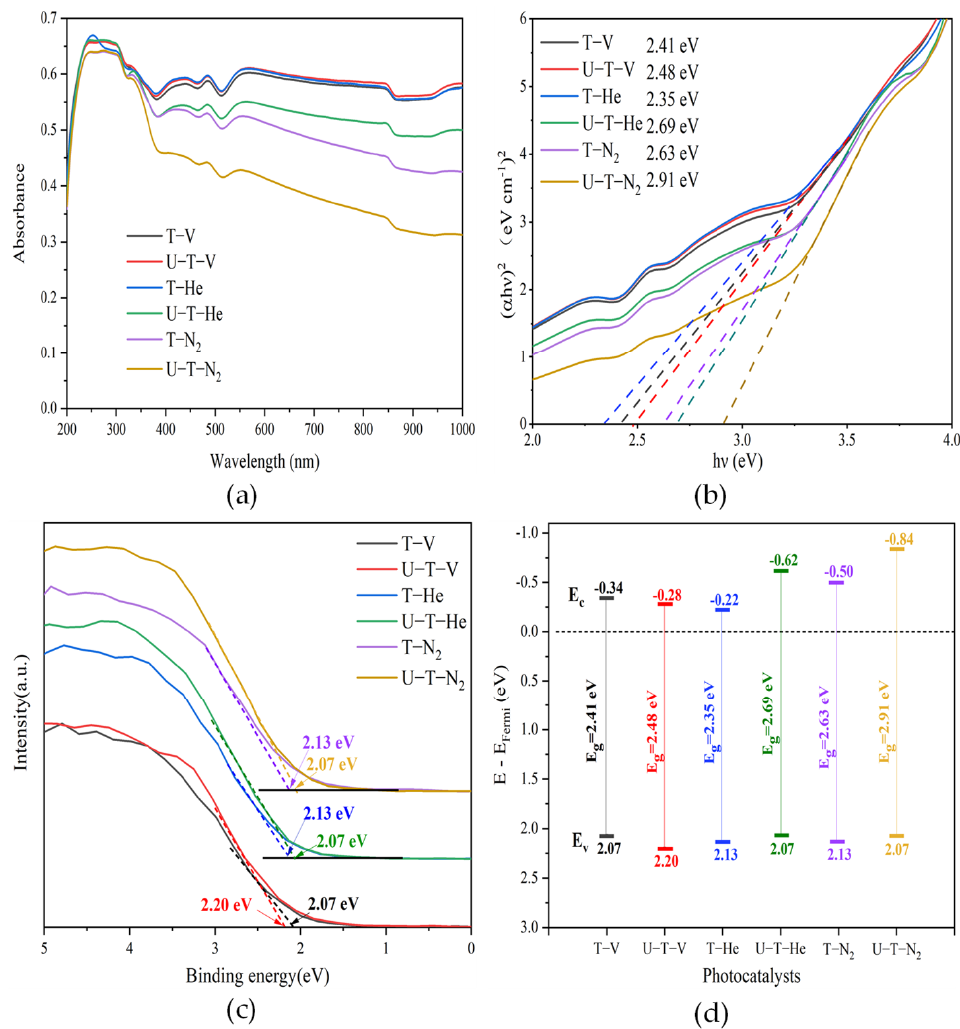
Figure 4. ( a ) UV-vis spectral absorbance; ( b ) bandgap energies evaluated from the plots of ( α h ν ) 2 versus h ν ; ( c ) XPS valence band (VB) spectra; ( d ) the calculated band energy.